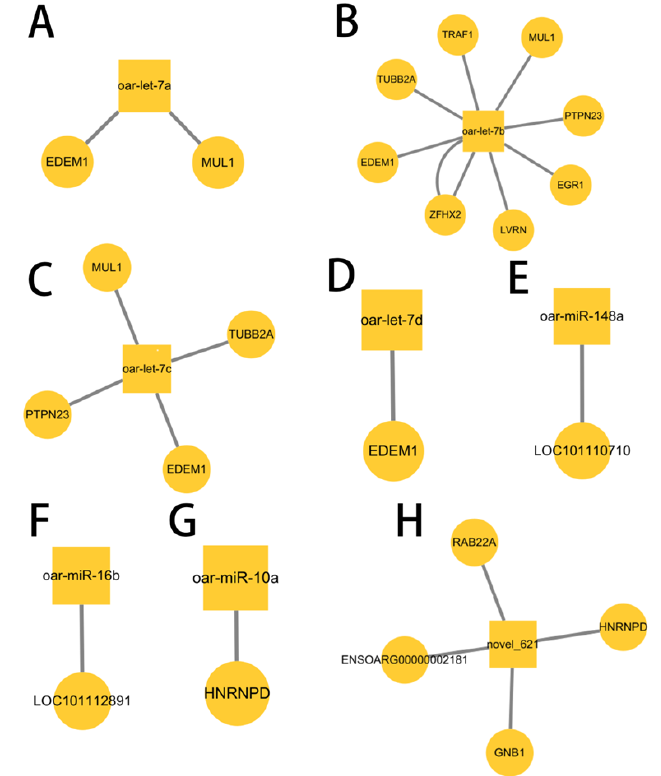
Figure 9. miRNA-mRNA co-expression network diagram. Squares represent miRNAs, circles represent mRNAs, and lines represent interactions. It can be seen from the figure that one miRNA can regulate multiple genes and a single gene can also regulate multiple miRNAs.